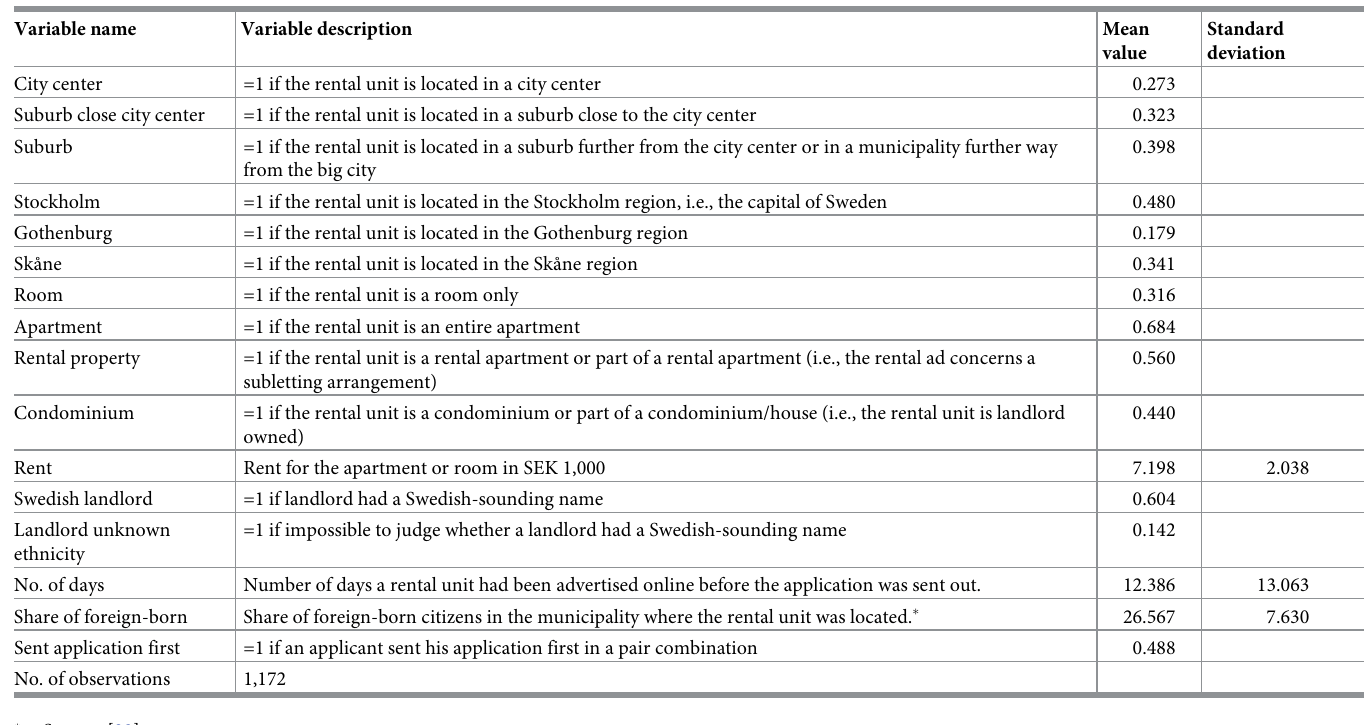
Table 2. Descriptive statistics of the